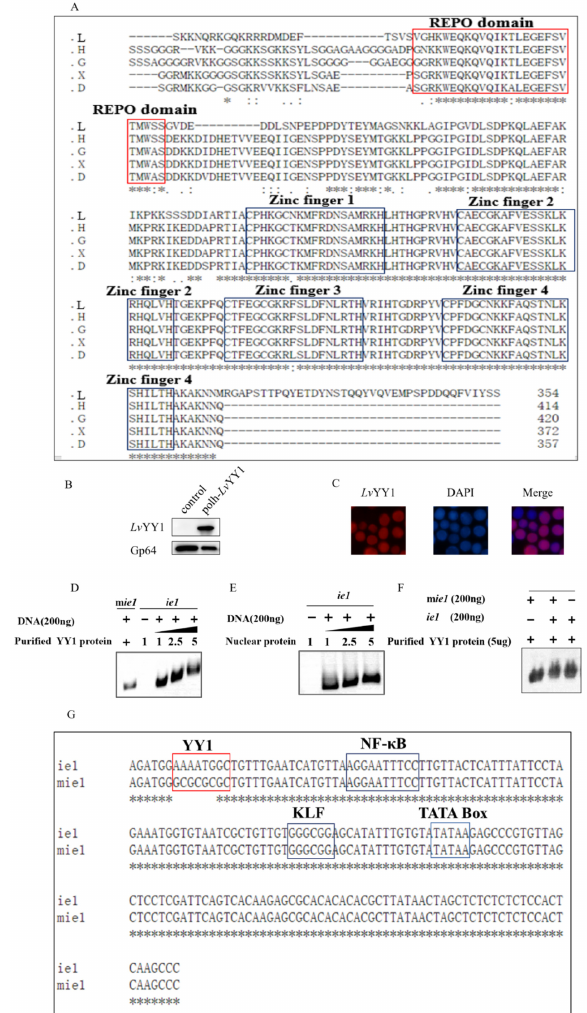
Figure 2. Lv YY1 expressed in Sf-9 cells and bound to WSSV ie1 promoter. ( A ) Lv YY1 (GenBank accession no. AOT21999.1) amino acid sequences were compared with human YY1(GenBank